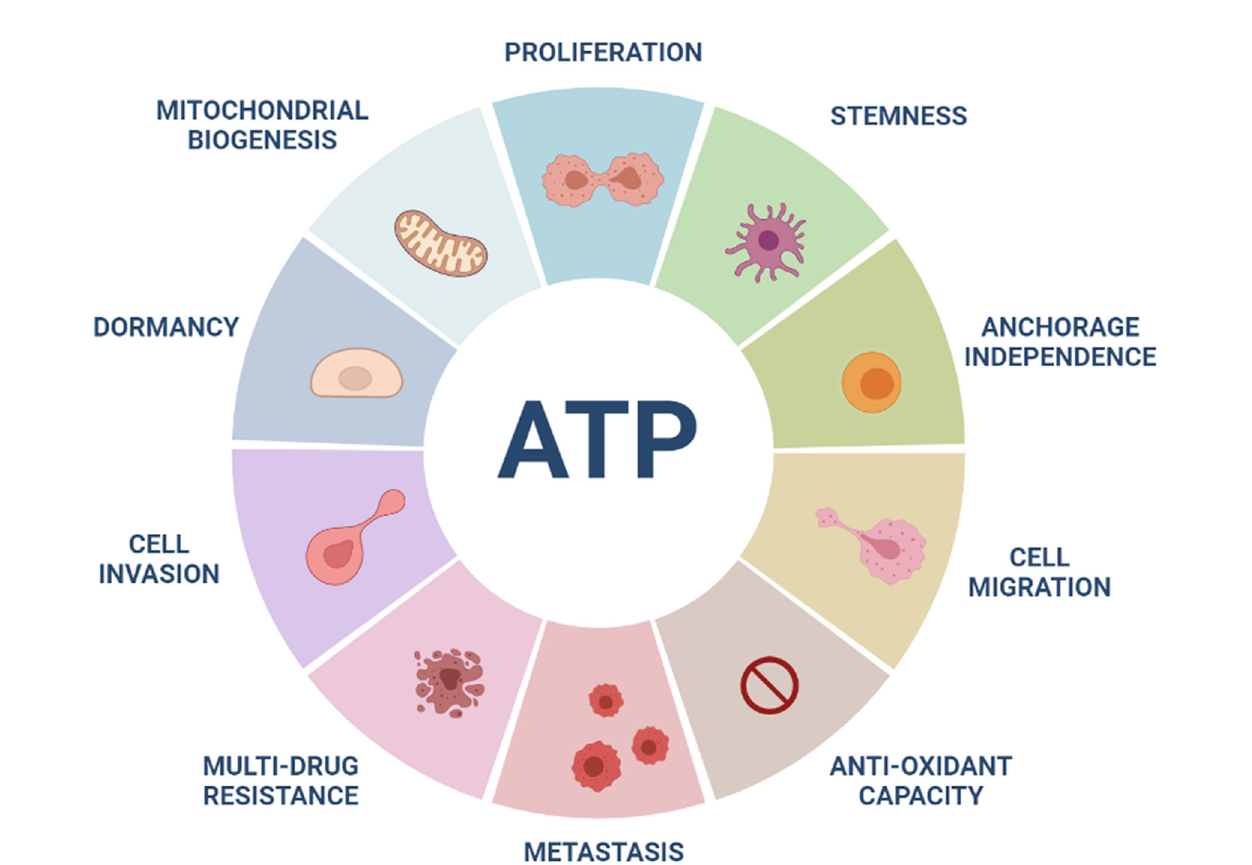
FIGURE 3 | High ATP levels are a major driver of aggressive cancer cell phenotypes. ATP-high cancer cells show increases in many aggressive properties or behaviors, including cell proliferation, stemness, anchorage-independence, migration, invasion, metastasis, anti-oxidant capacity and drug-resistance. In contrast, more “ dormant ” CSCs show low ATP levels. High mitochondrial ATP production may be related to increases in mitochondrial mass in ATP-high cancer